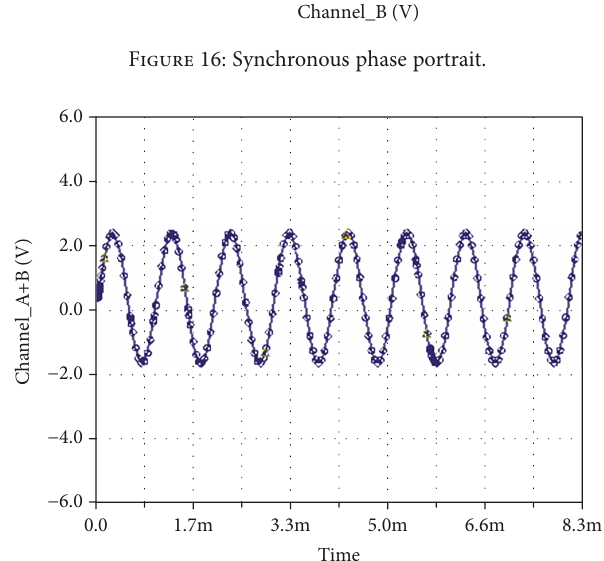
Figure 17: Superimposed signal